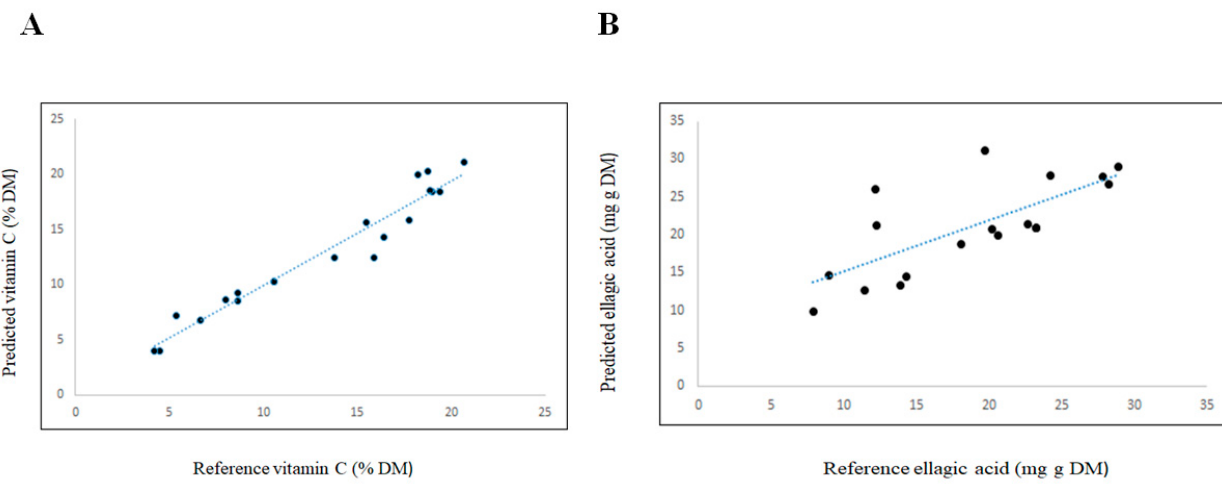
Figure 3. Scatter plot for the validation ( n = 20) of the measurement of vitamin C (Panel ( A )) and ellagic acid (Panel ( B )) in the pureed Kakadu plum samples.